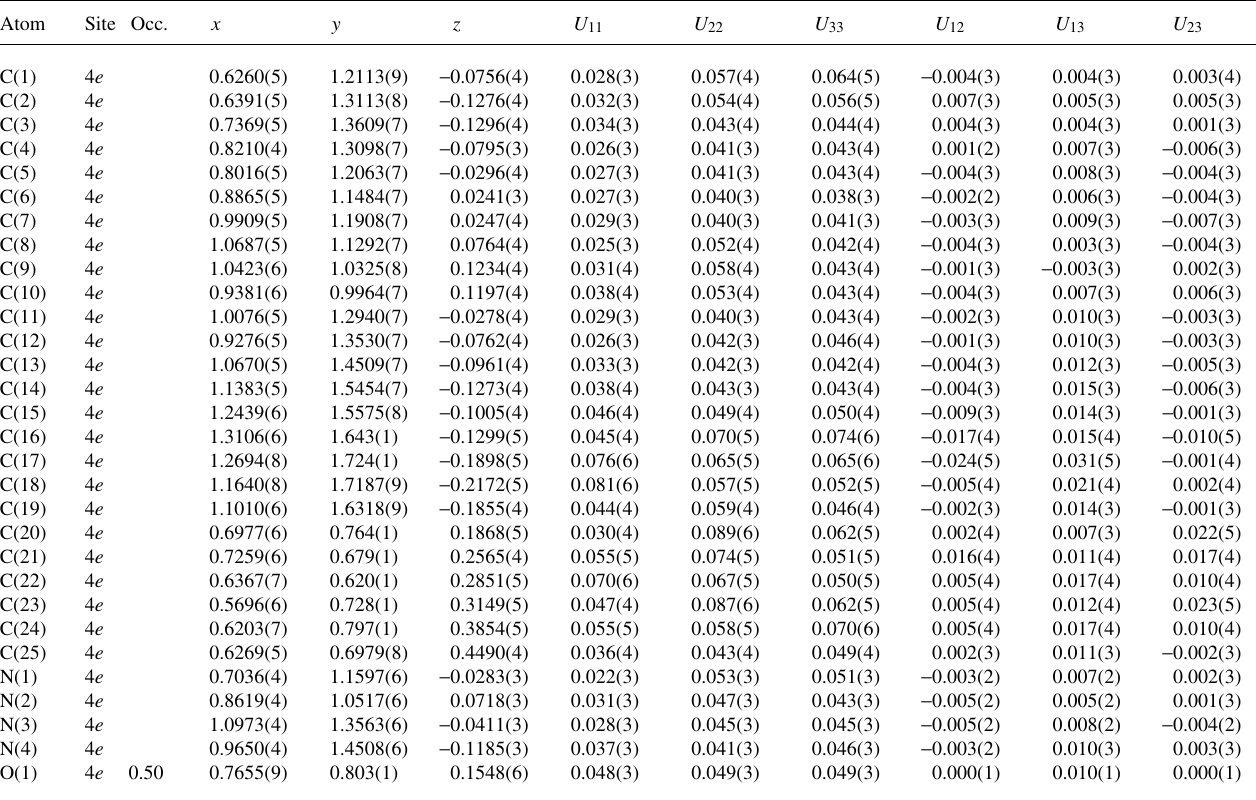
Table 3. Atomic coordinates and displacement parameters (in Å 2 ) . Atom Site Occ.